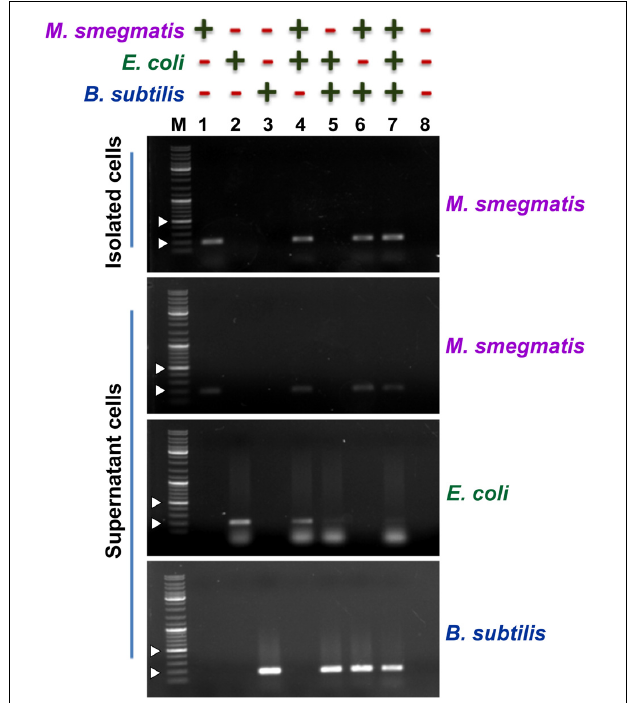
FIGURE 4 | Detection of the presence of bacteria after magnetic separation from mix-samples. The assay was carried out with a bacterial sample having presence (+) or absence ( − ) of M. smegmatis , E. coli , and B. subtilis as indicated. Agarose gels show the PCR amplicon obtained after carrying out PCR with either the pulled-down cells or the cells present in the supernatant after magnetic separation. Lanes 1–8 represent all the different combinations of samples. PCR was performed using mno gene primer for M. smeg matis, lacZ gene primer for E. coli , and rpoB gene primer for B. subtilis . Obtained amplicon sizes are 188 bp for mno , 210 bp for lacZ , and 161 bp for rpoB . “M” represents the DNA ladder with two bands of 200 and 500 bp marked with white